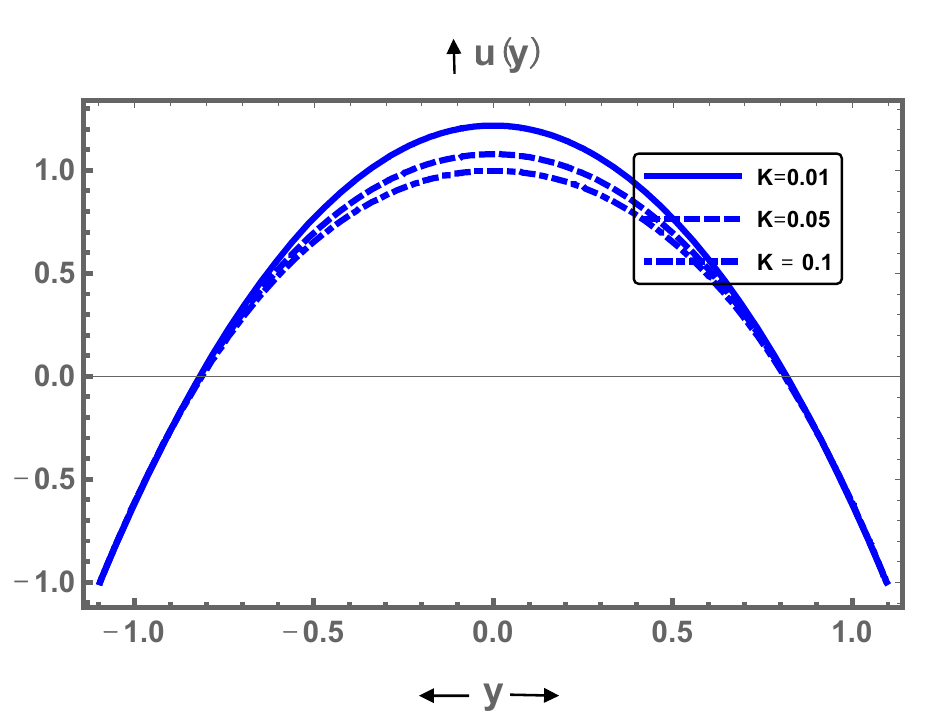
Figure 10. Display of axial velocity for different values of K .